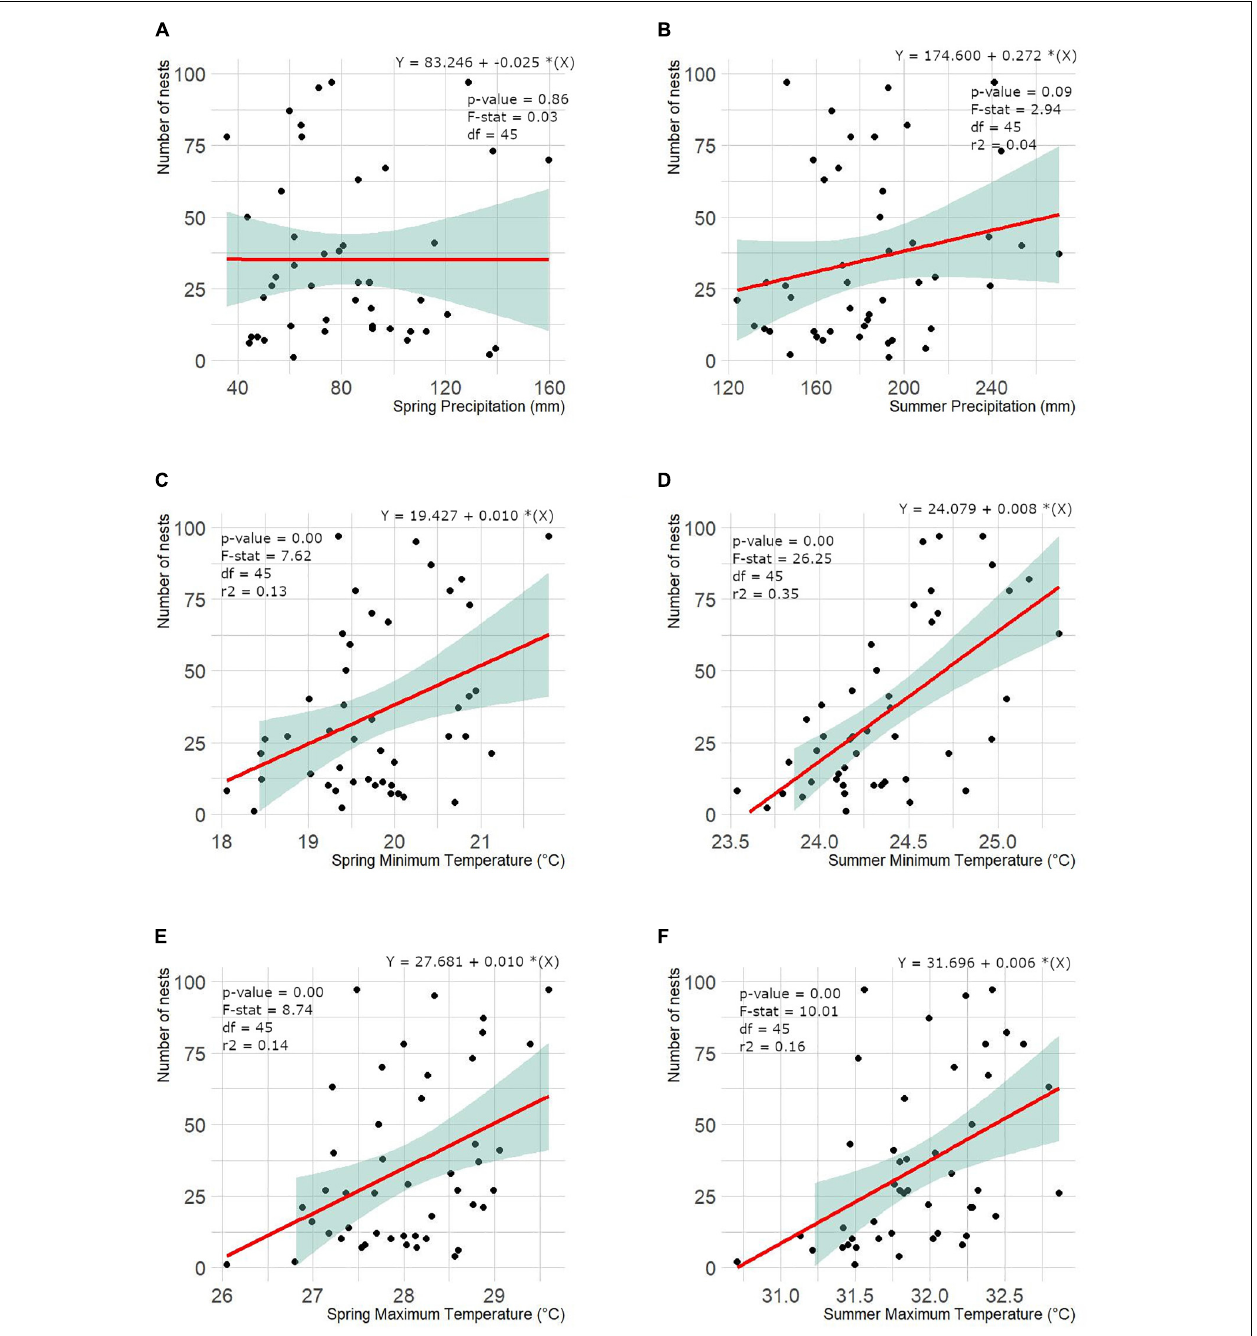
FIGURE 5 | Linear relationship between the number of nests found by year and the mean precipitation (A,B) , minimum (C,D) and maximum (E,F) temperature reported across South Florida from 1970 through 2018. Solid red line represents the linear model predicted and the shaded area represents the standard error of the model. All relationships showed weak-to-strong evidence for positive effect of environmental parameters on number of nests except for spring precipitation and number of